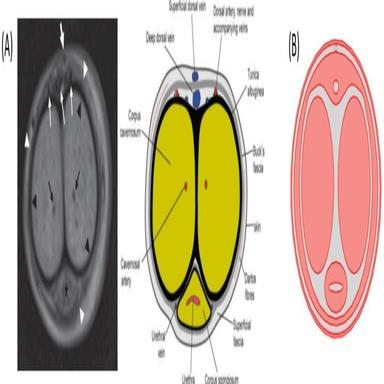
(A) MRI scan and schematic of penis cross section, (B) the FE model constructed from the MRI scan.